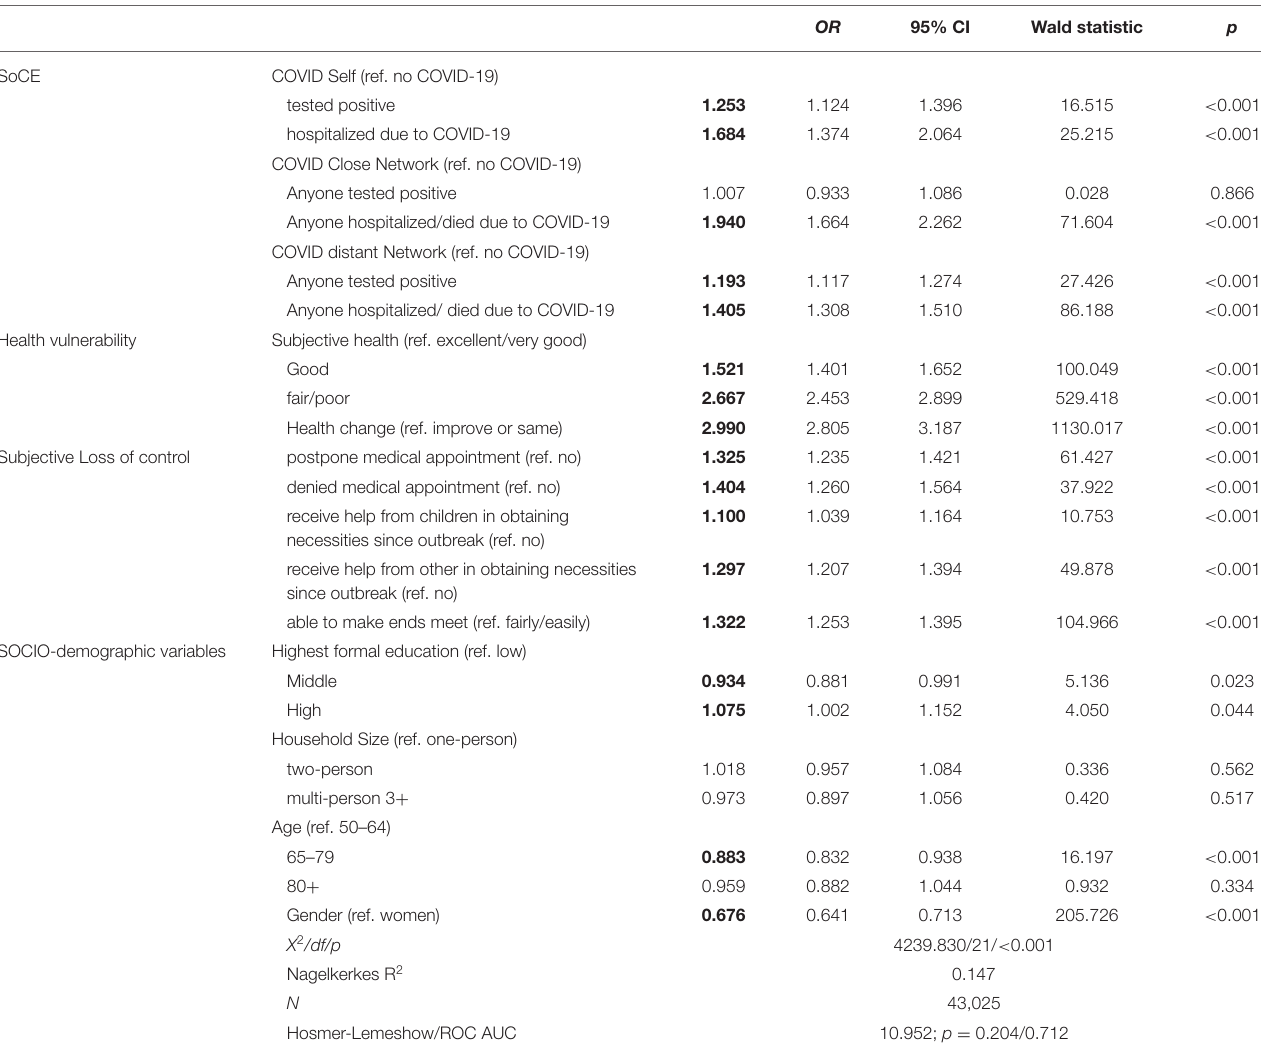
TABLE 4 | Logistic regression model predicting increased psychological